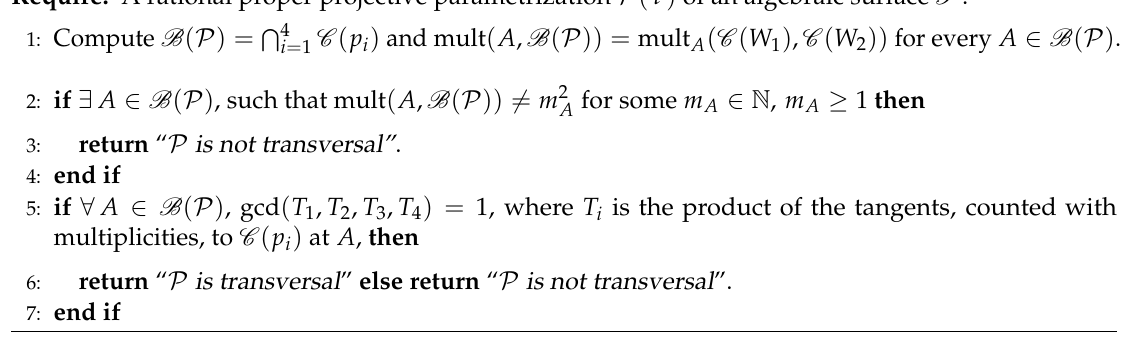
Algorithm 1 Transversality of a